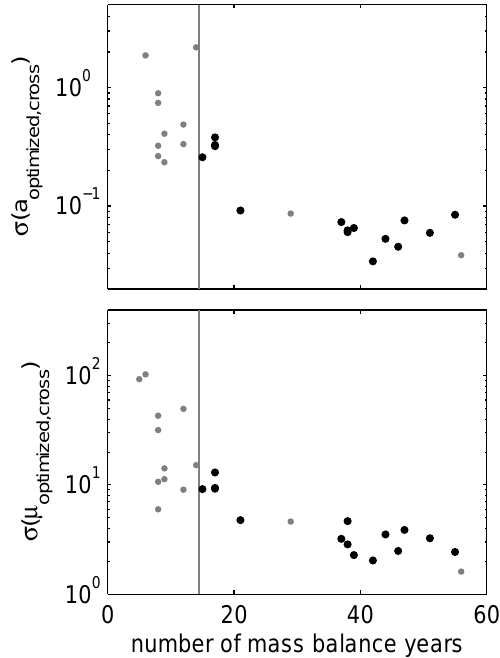
Fig. 4. Standard deviation of a optimized , cross (top) and µ optimized , cross (bottom) as a function of the number of MB measured . Black dots are the values of the glaciers accepted into the final set, gray dots are those of the rejected glaciers. The gray vertical line indicates the minimum number of mass balances nec- essary to yield robust results for a optimized and µ optimized